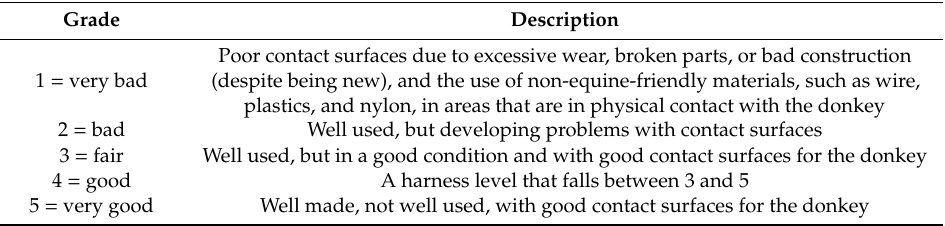
Table 1. The harness condition scores.